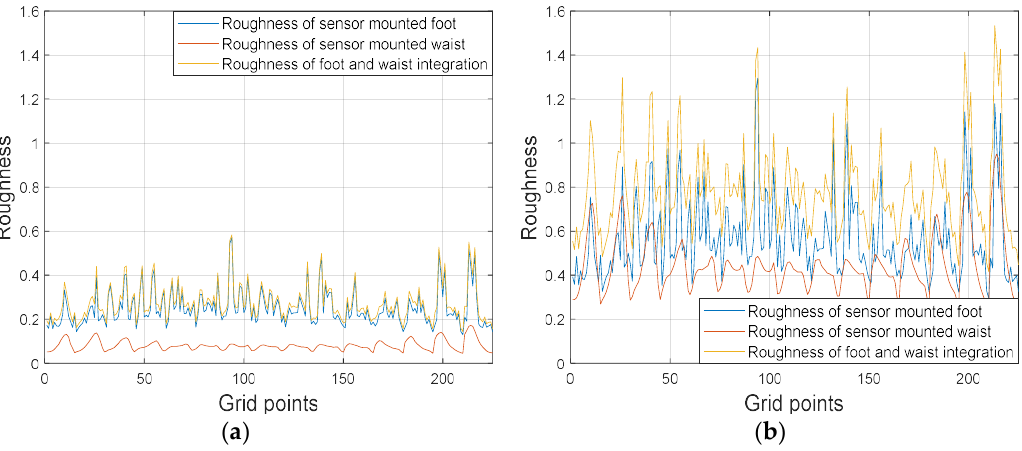
Figure 3. Magnetic-map roughness (( a ) is for simple integration case and ( b ) is for normalized integration case with roughness weighting factors).